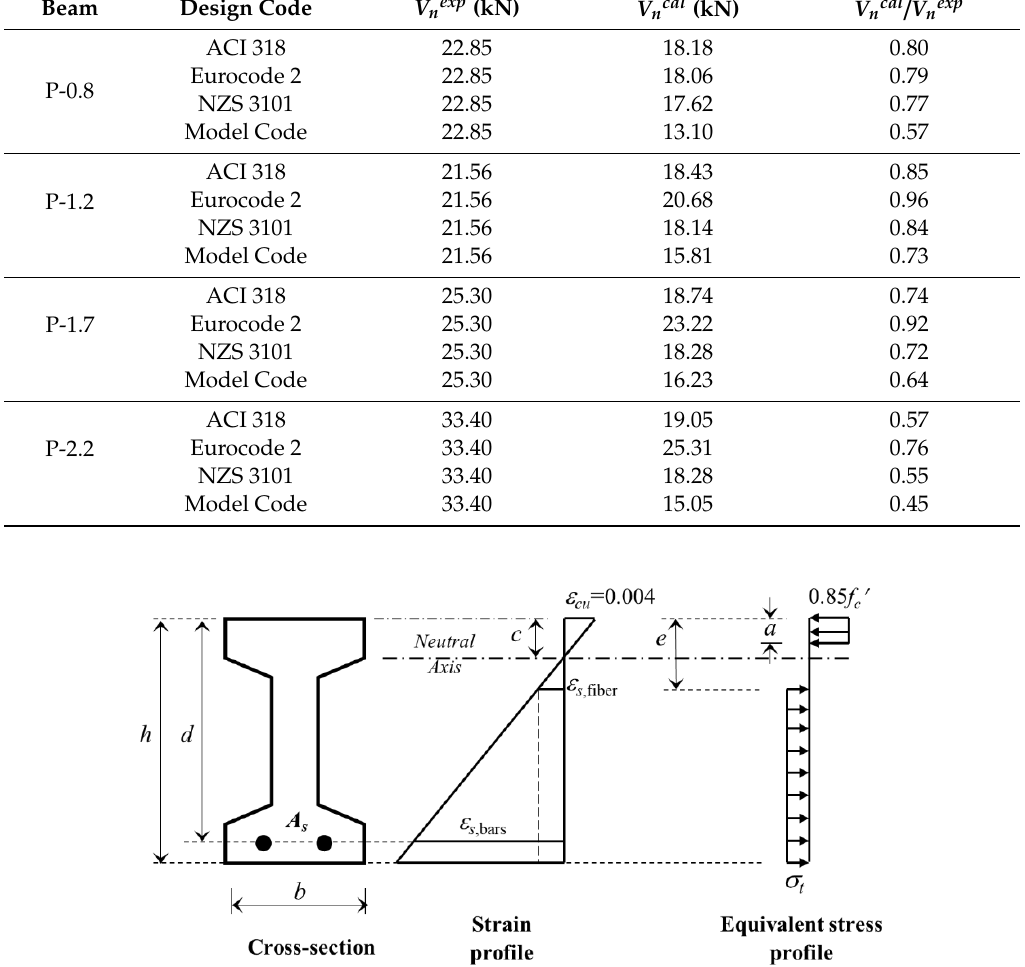
Figure 9. The strain and stress distributions relation to numerical model [53]. Table 6. Numerical analysis results of the Steel Fiber-Reinforced (SF)-UHPC beams.